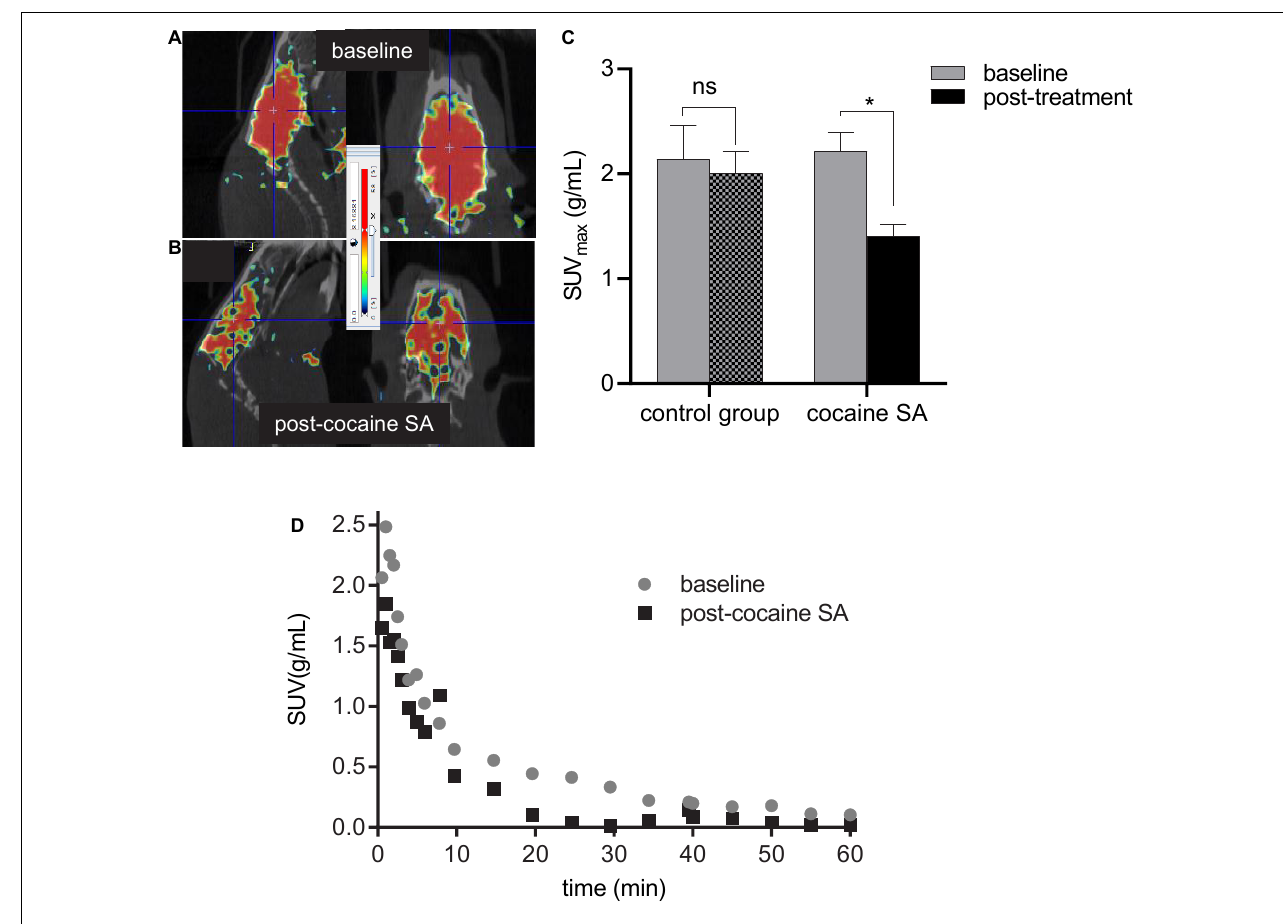
FIGURE 2 | Representative microPET/CT image of a cocaine SA rat brain at (A) baseline and (B) post-cocaine treatment with [ 11 C]MPC-6827 and their whole-brain (C) SUV max and (D). TACs; ns, non-significant, * p = 0.043.